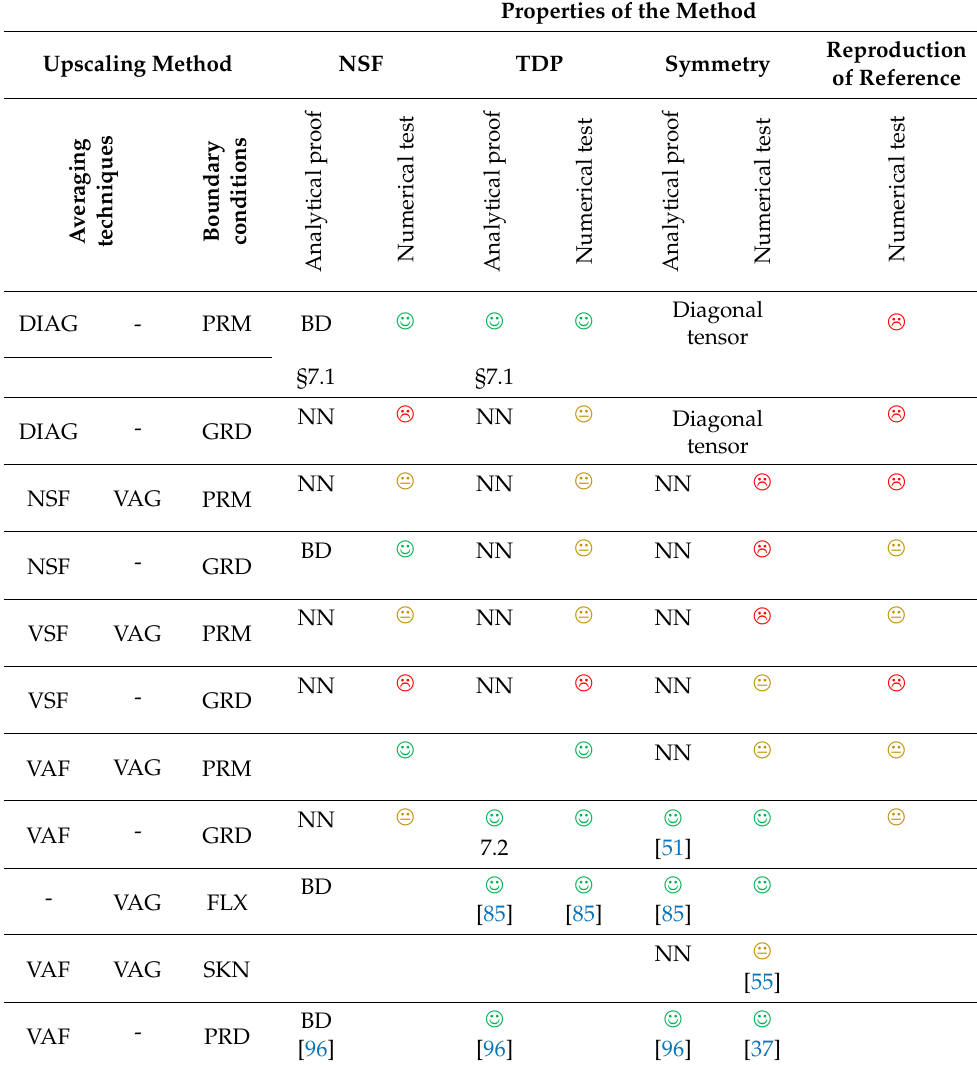
Table 4. Main properties of the upscaling techniques discussed in this paper. Properties of the Method